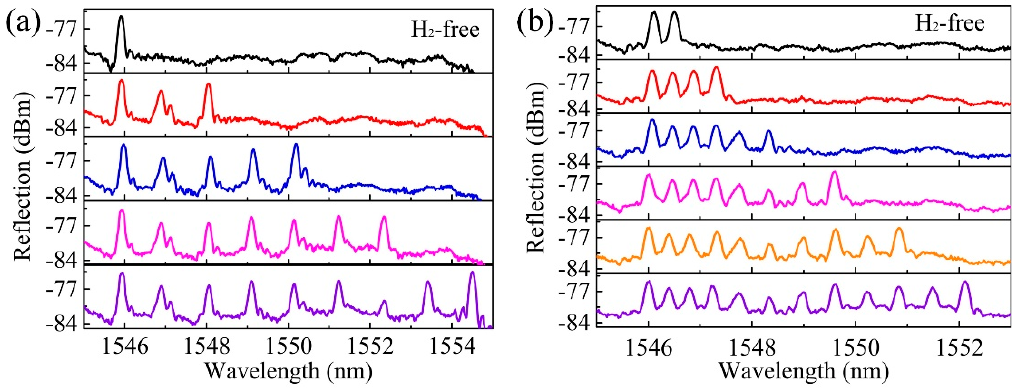
Figure 4. Reflection spectrum evolution of an FBG array inscribed with the ( a ) common fiber holder method and ( b ) with a mass block hanging on one end of the fiber. The peak separations are of ~1 nm and ~0.4 nm, respectively.